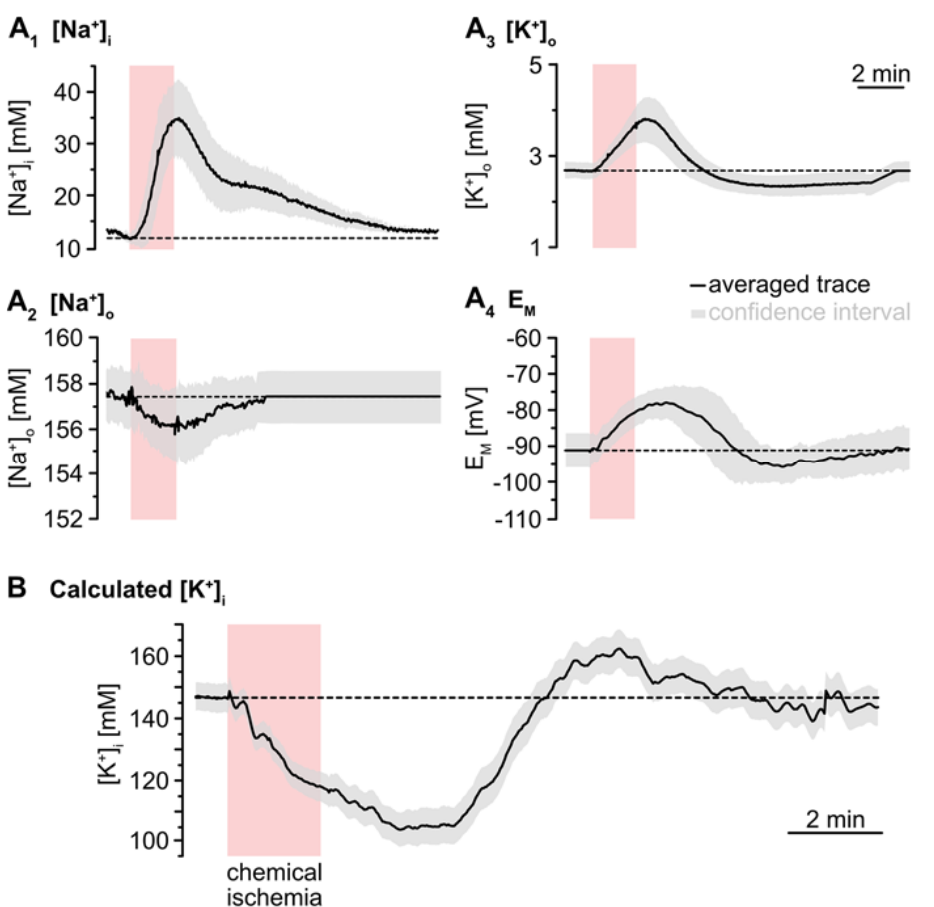
Figure 4. Simulation of ischemia ‐ induced changes in astrocytic [K + ] i . ( A ) Traces show averaged changes of [Na + ] i , [Na + ] o , [K + ] o and E M . The grey envelopes show the 95% confidence intervals. ( B ) The change in astrocytic [K + ] i upon chemical ischemia was calculated from feeding the average traces shown in ( A ) into Equation (2). The grey envelope again depicts the 95% confidence interval, which was calculated from the individual confidence intervals given in ( A